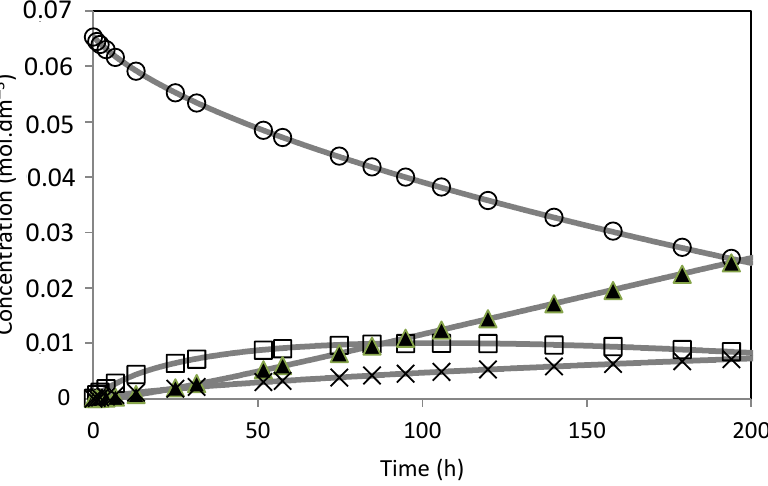
Figure 15. Camphene hydration over PW1-SBA-15-SO 3 H catalyst. ( ) Camphene; ( ) Camphene hydrate; ( ) Isoborneol; ( × ) Others. The lines represent the model fitted to the experimental points.